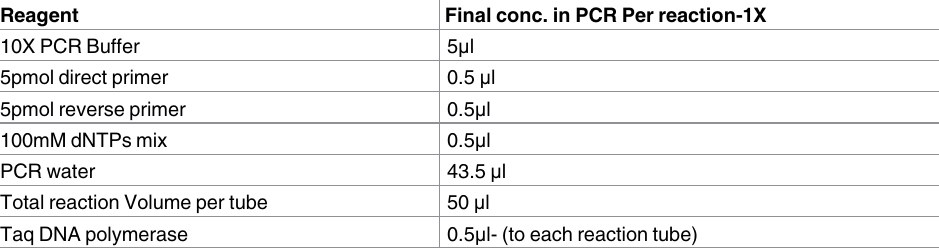
Table 2. Master mix